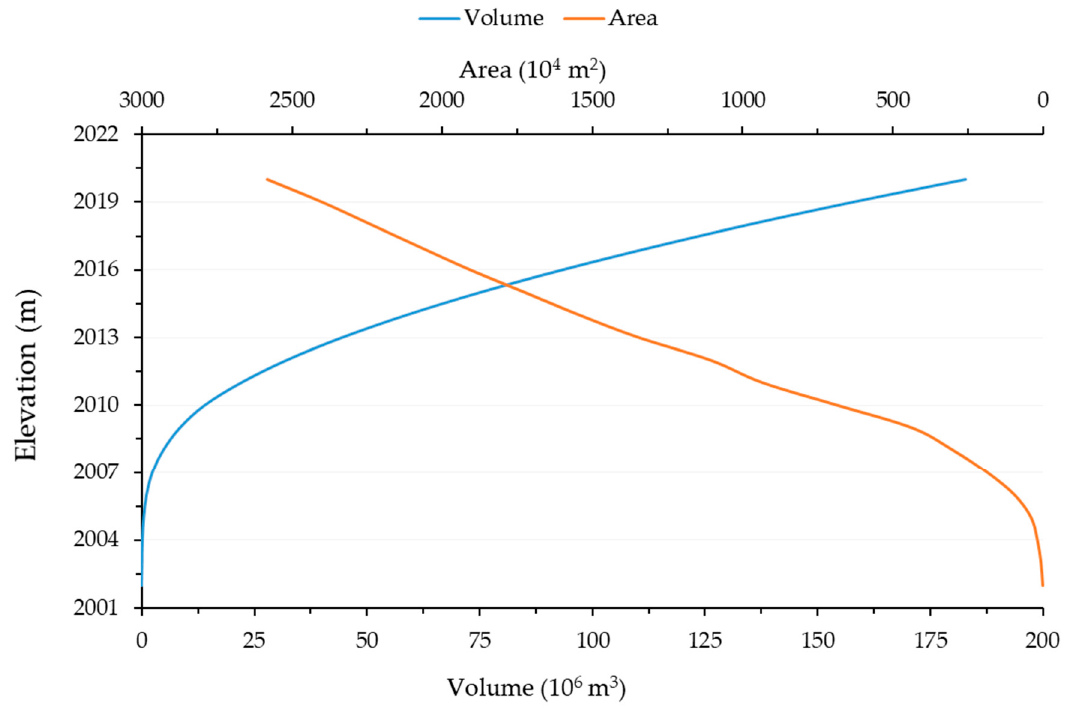
Figure 4. Koga reservoir characteristics (stage-capacity and stage-area relationship).